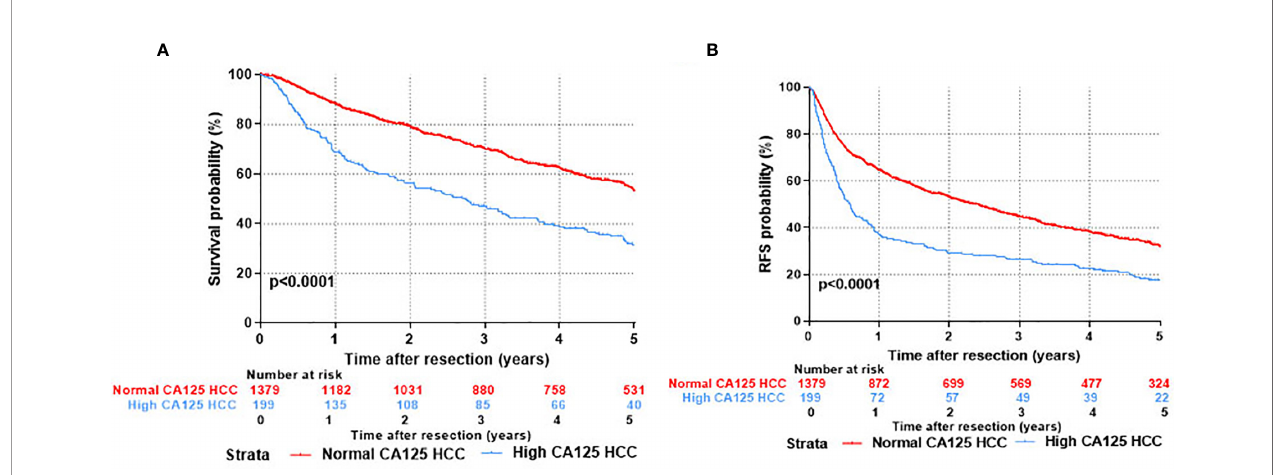
FIGURE 2 | Comparison of prognosis after hepatic resection between normal CA125 and high CA125 HCC groups. (A) Overall survival. (B) Recurrent free